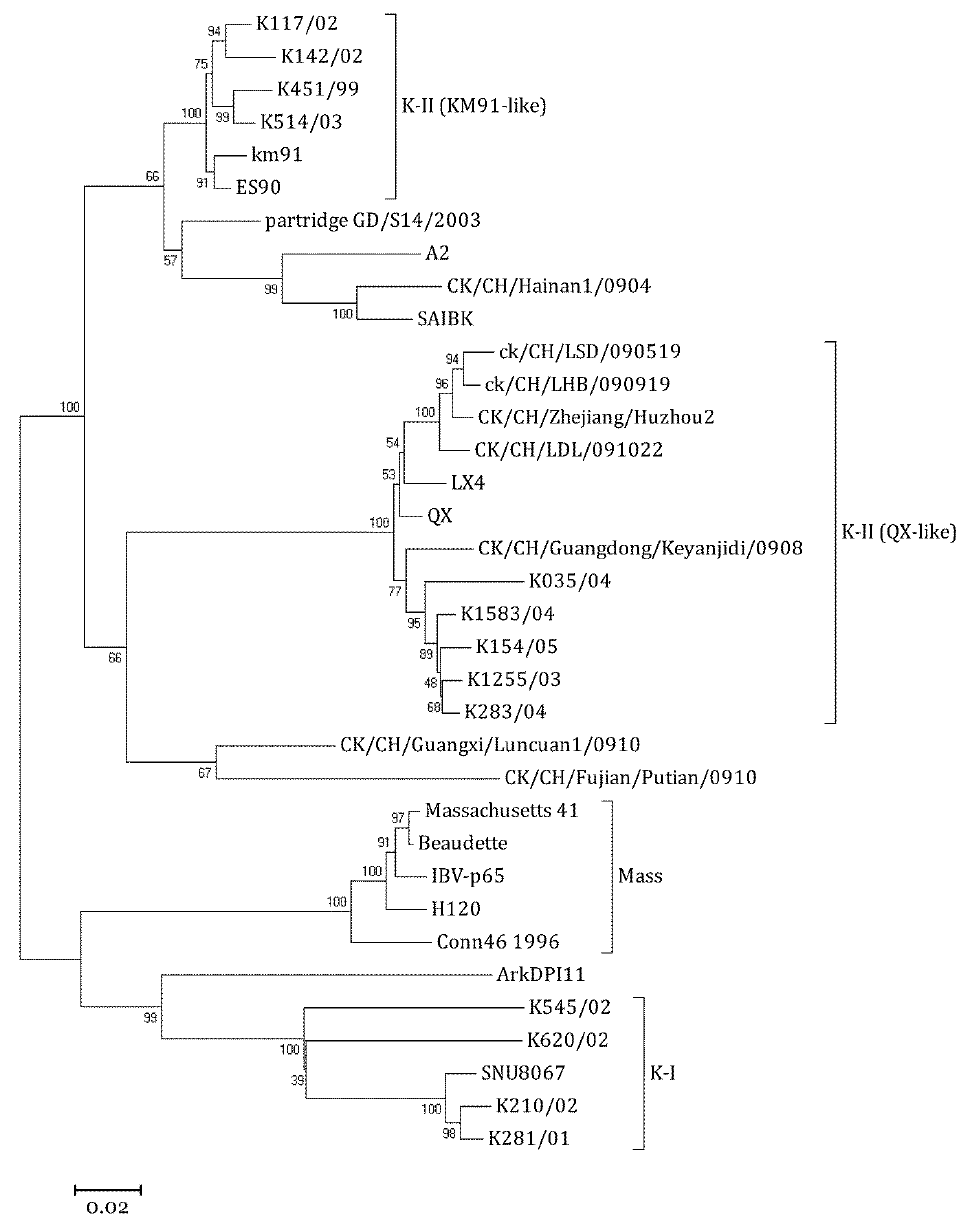
Figure 1. Phylogenetic analysis of the S1 genes of infectious bronchitis viruses. The phylogenetic tree was constructed by the neighbor-joining method (Kimura-2 distance, 500 repeats of